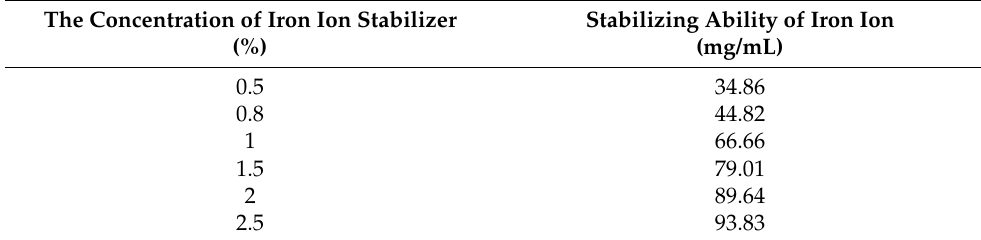
Table 4. Performance of iron ion stabilizer in different concentration.